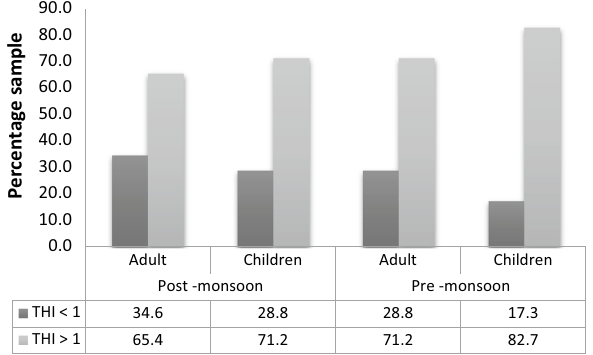
Fig. 9 Total hazard index value in percentage with Adult and children for both